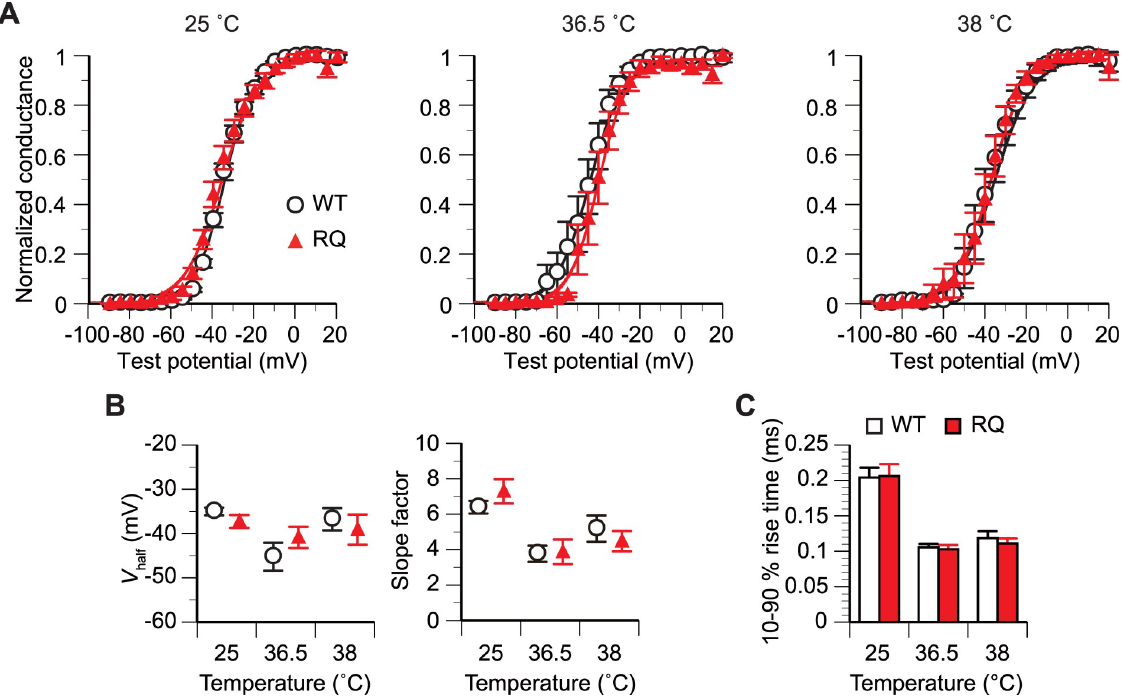
Fig 2. SCN5A(R1193Q) did not affect the activation gating at any tested temperature. (A) Mean relative peak g-V plots converted from the peak I-V plot in Fig 1B. The Boltzmann sigmoidal function was fitted to the data from all examined cells for each condition. n, 10–11 WT cells and 9–11 RQ cells for each condition. (B) Comparison of the mean V half and slope factor estimated from the Boltzmann function fitted to the g-V plot for each cell. p > 0.05 between WT and RQ cells for all temperatures (unpaired t -test). n, 10–11 WT cells and 9–11 RQ cells for each condition. (C) Comparison of the mean 10%–90% rise time measured on the current response evoked at a test potential of –20 mV. p > 0.05 between WT and RQ cells for all temperatures (unpaired t -test). n, 7–10 WT and 7–8 RQ cells for each